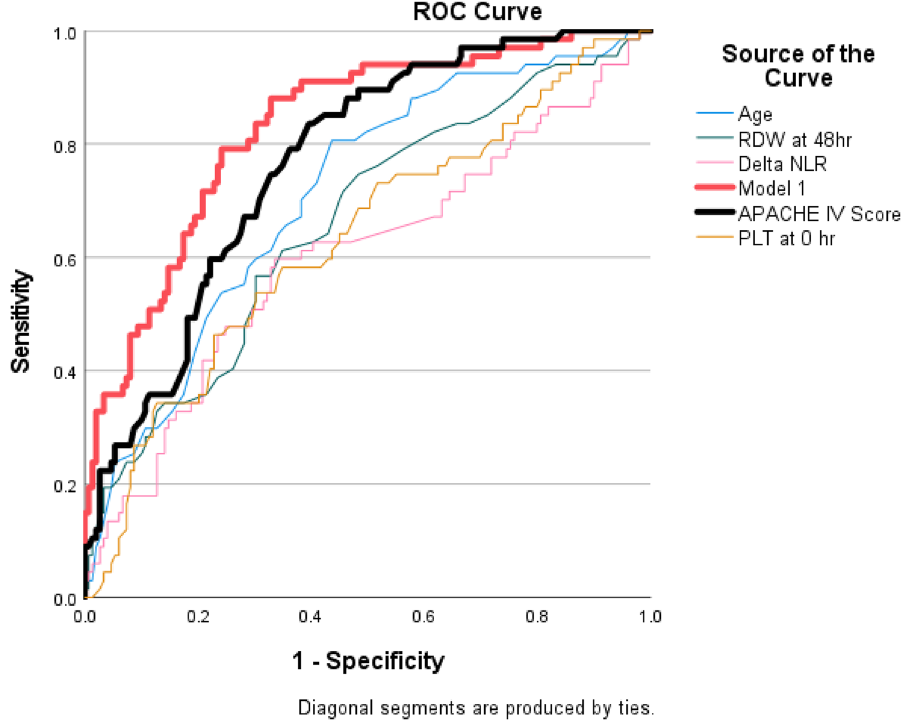
Figure 1. Receiver operating characteristic (ROC) curves to compare the performance of the APACHE IV score and Model 1. Model 1 (logistic regression model from Table 4): AUROC 0.830, 95% CI 0.772–0.888. APACHE IV score: AUROC 0.769, 95% CI